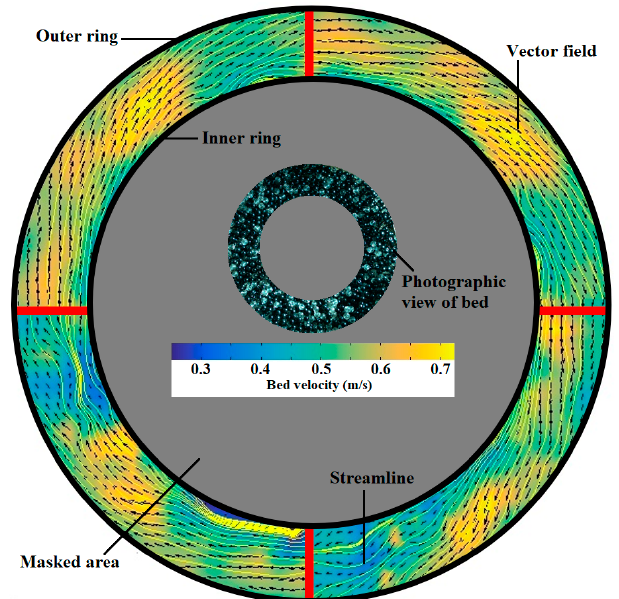
Figure 4. A vector field of a bed fluidized above U m . Inset provides a photographic view of the swirling bed. Processes 2020 , 8 , x FOR PEER REVIEW